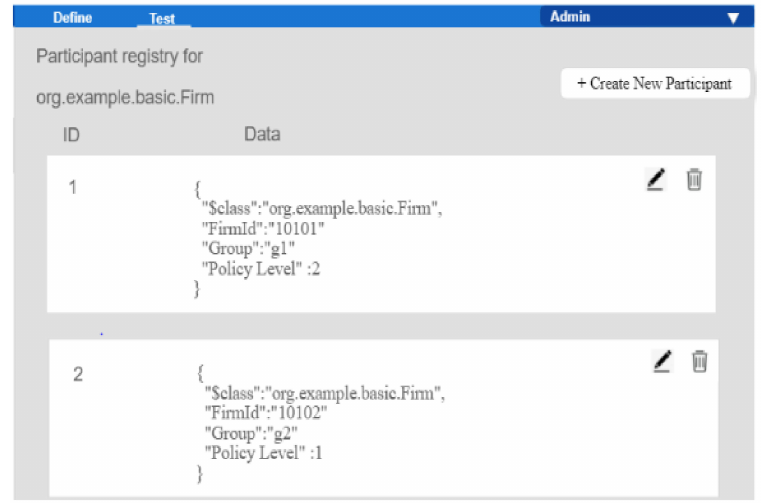
Figure 15. Administrator setting permissions.